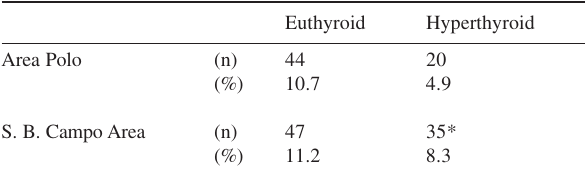
Table 3 - Prevalence of hypothyroidism (associated with chronic autoimmune thyroiditis) in both areas.